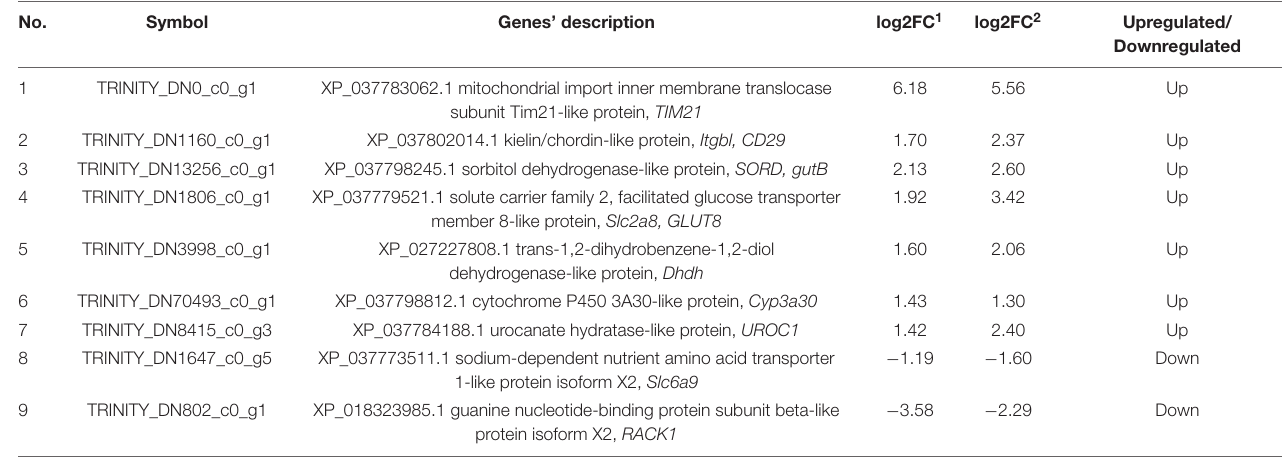
1 From the comparison of FCN10 vs. FCM10. 2 From the comparison of FCN25 vs. FCM25.